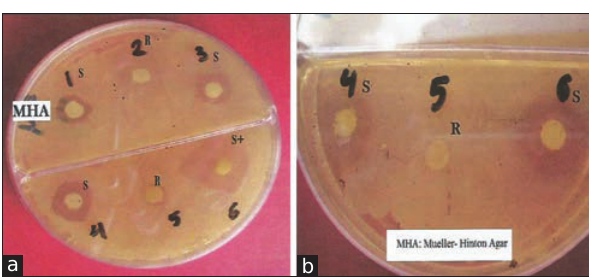
Figure-4: Antimicrobial activity of plant extracts on bacteria isolated from bovine mastitis by disk diffusion method (a) (1,3,4 and 6) inhibition around the discs or resistant (R) as in (2 and 5) no inhibition zone around the desk. (b) susceptible (S) as in (4 and 6) or resistant (R) as in